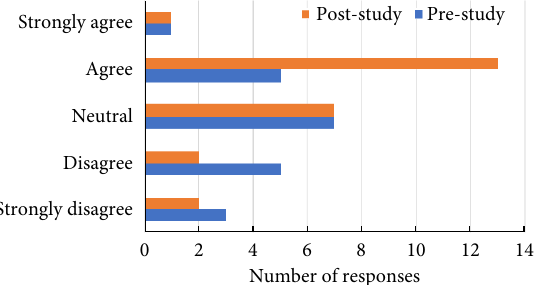
Fig. 6 Participants ’ self-reported capability of making design decisions related to fairness before and after using